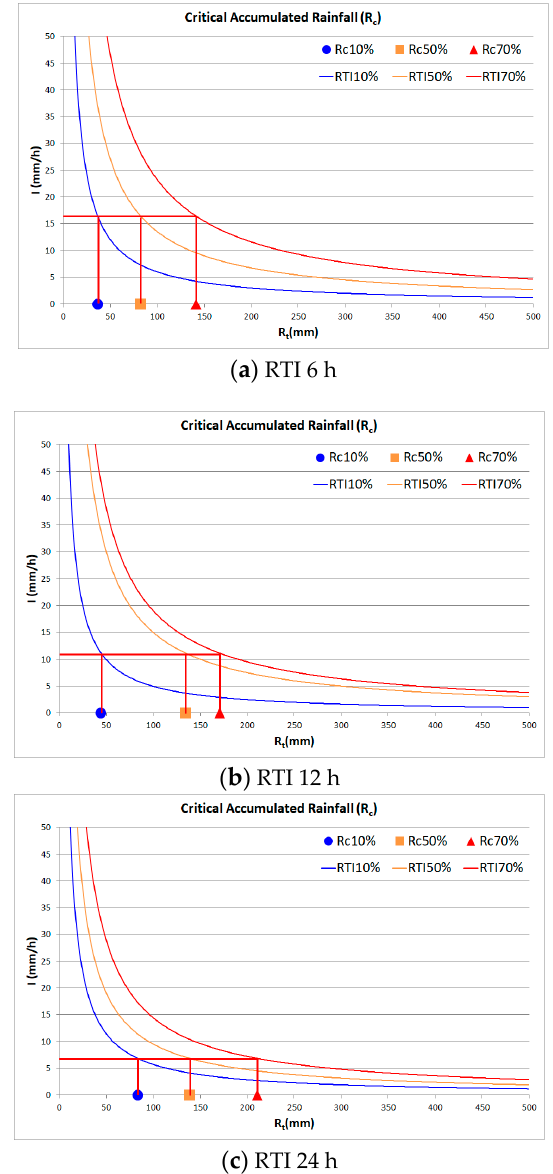
Figure 12. Estimation of rainfall triggering index (RTI) and critical accumulated rainfall ( 𝑅 𝑐 ) : ( a ) RTI 6 h; ( b ) RTI 12 h; ( c ) RTI 24 h. Table 5. Estimation of critical accumulated rainfall ( 𝑅 𝑐 ).